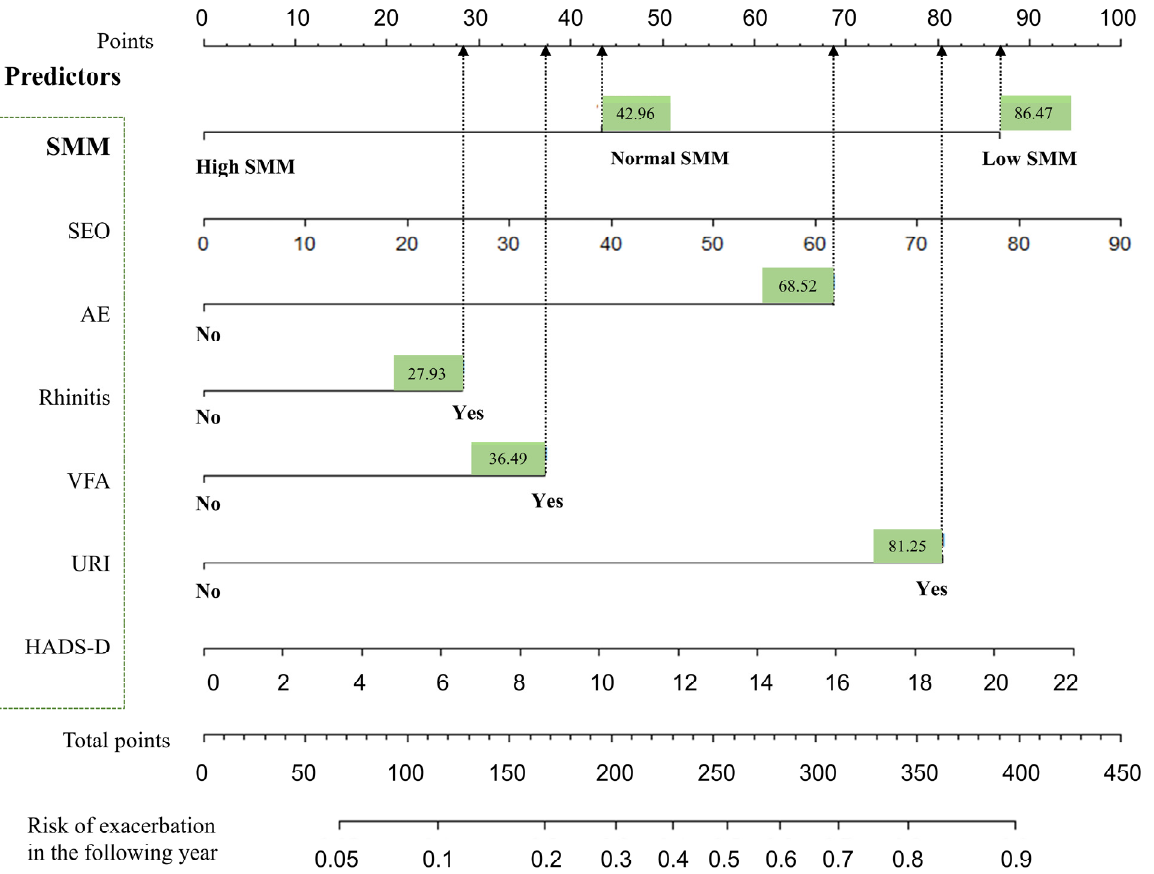
Figure 4. Asthma future exacerbation nomogram. The asthma future exacerbation nomogram was developed on the basis of established multivariable regression models in the whole cohort population. Using the nomogram, the probability of future asthma exacerbation in the following year can be estimated as follows. First, the judgment on predictor variables (e.g., yes or no, SMM Low or SMM High ) can be obtained from patients. Second, if a predictor is judged as “Yes”, the value of the predic- tor can be designated by drawing an upward straight line from “Yes” up to the “Points” line. Third, add up the points of all the predictors assessed as “Yes” to get the total points. Finally, the proba- bility of future asthma exacerbation in the following year can be obtained by drawing a straight line from the “Total Points line” down to the “Risk of exacerbation in the following year” line. SMM, skeletal muscle mass; VFA, visceral fat area; D, HADS-D; SEO, sputum eosinophils; URI, previous upper respiratory infection induced asthma attack. 3.5.3. Performance of the Prediction Model and Clinical Applicability of the Nomogram There were no significant differences in sociodemographic characteristics between the training and validation cohorts (Tables S7 and S8). The C-indices of the nomogram in the training and validation cohorts were 0.750 (95% CI: 0.691–0.810) and 0.793 (0.704– 0.882), respectively (Figure 5), indicating moderate accuracy. The p values of the HL tests